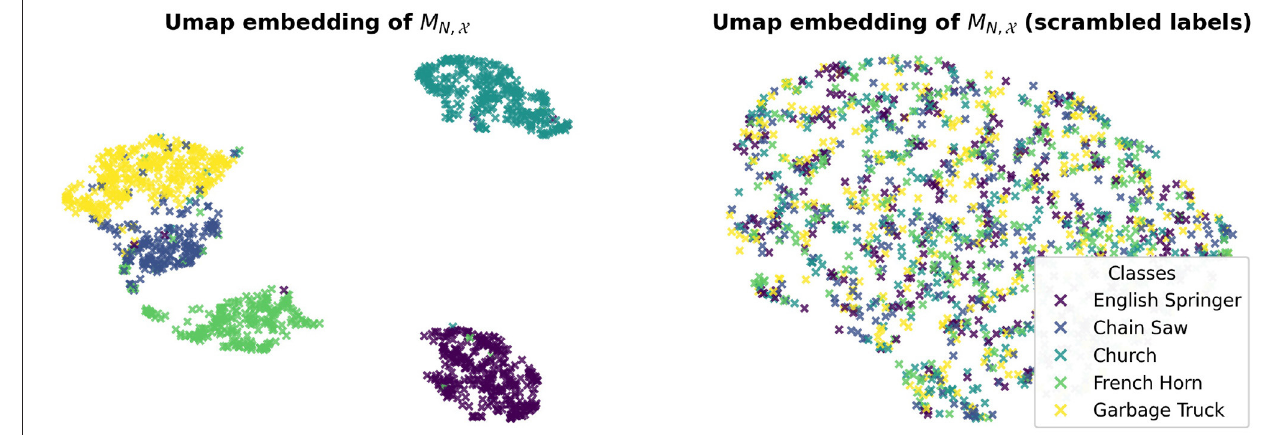
FIGURE 8 | Clustering of the output of a linear classifier learned to separate single image Fourier masks. M N , X indicates the set of single image masks computed for the correctly classified test images in X .